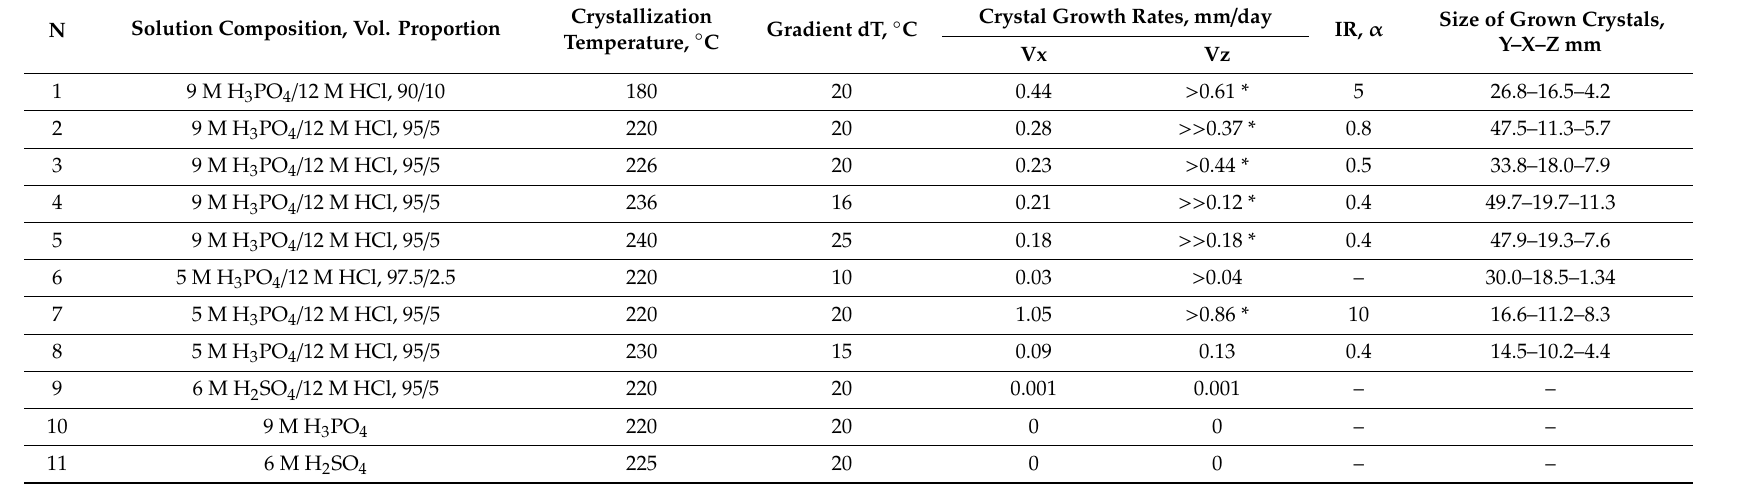
*—solution—the top part of the autoclave—and the nutrient basket, in other words, the temperature